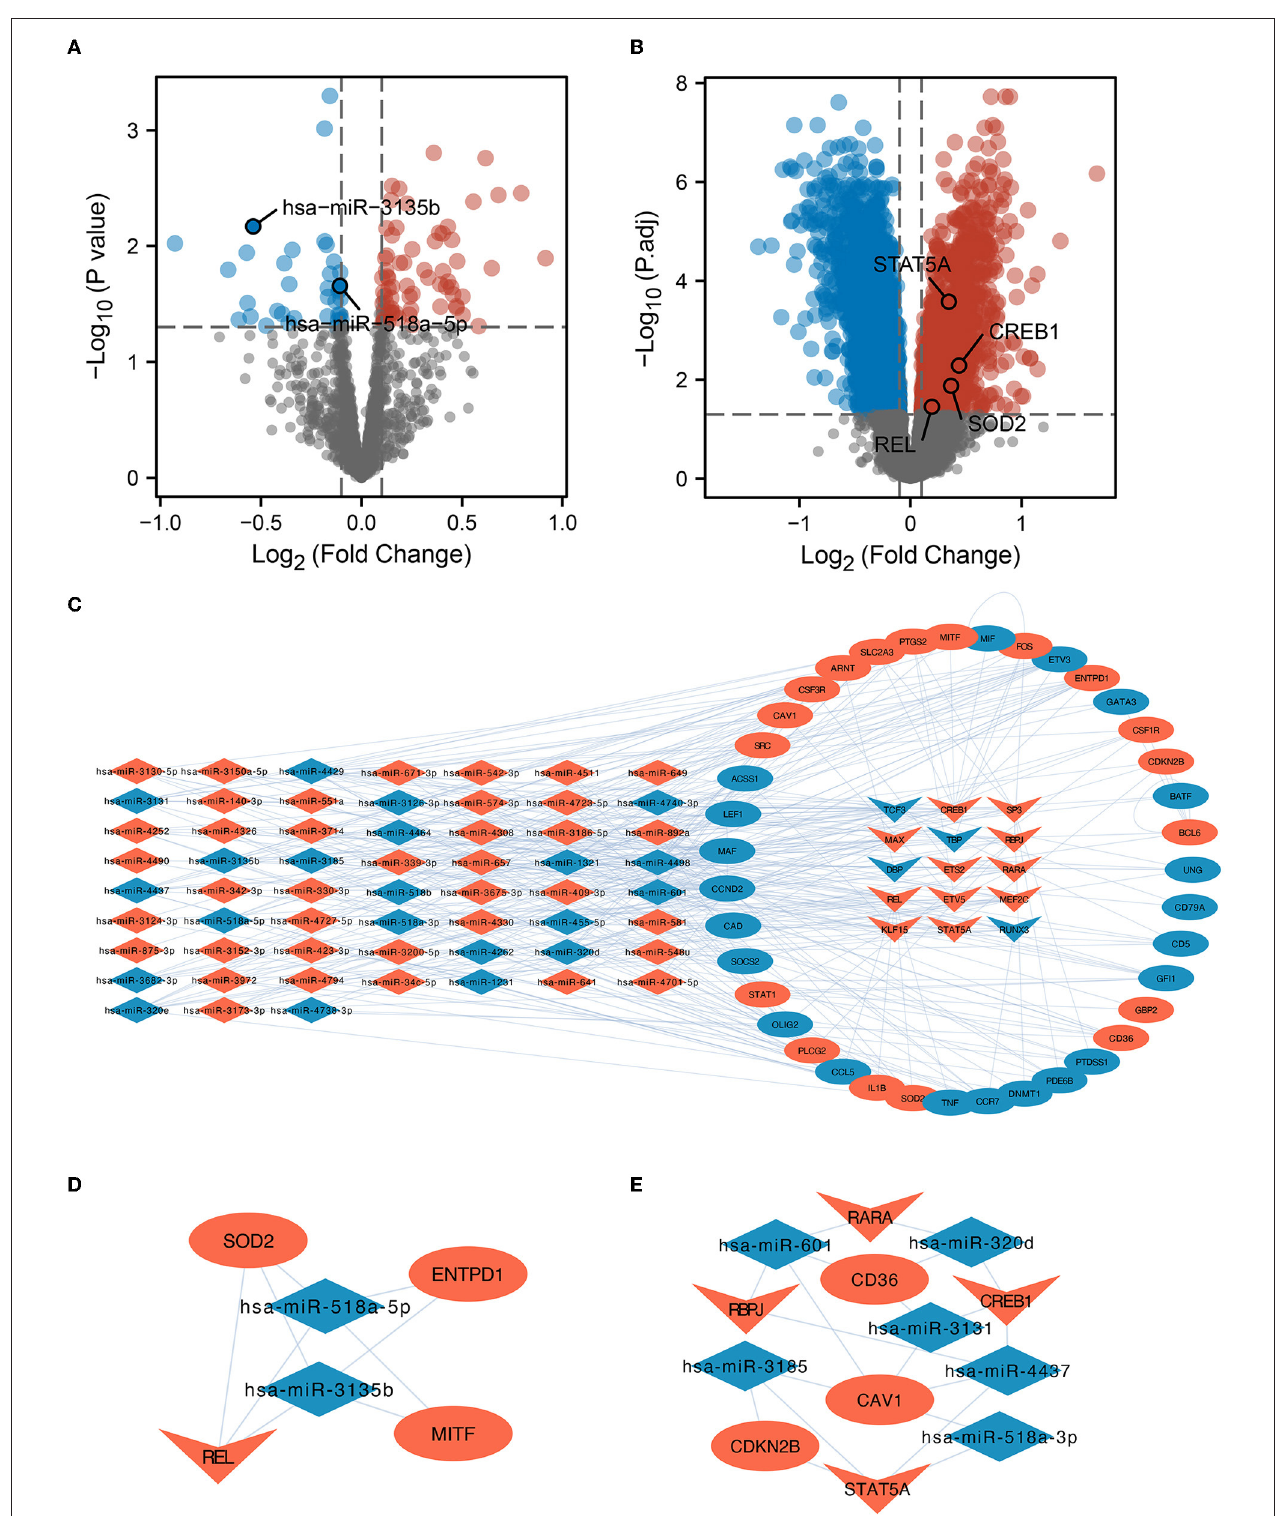
FIGURE 2 | Variance analysis and PPI network construction. (A) A map of differentially expressed micro RNAs (DEmiRNAs) in the form of a volcano. The important miRNAs were identified and tagged. (B) Differentially expressed messenger RNA (DE-mRNA) volcano map. The diagram labels important transcription factors